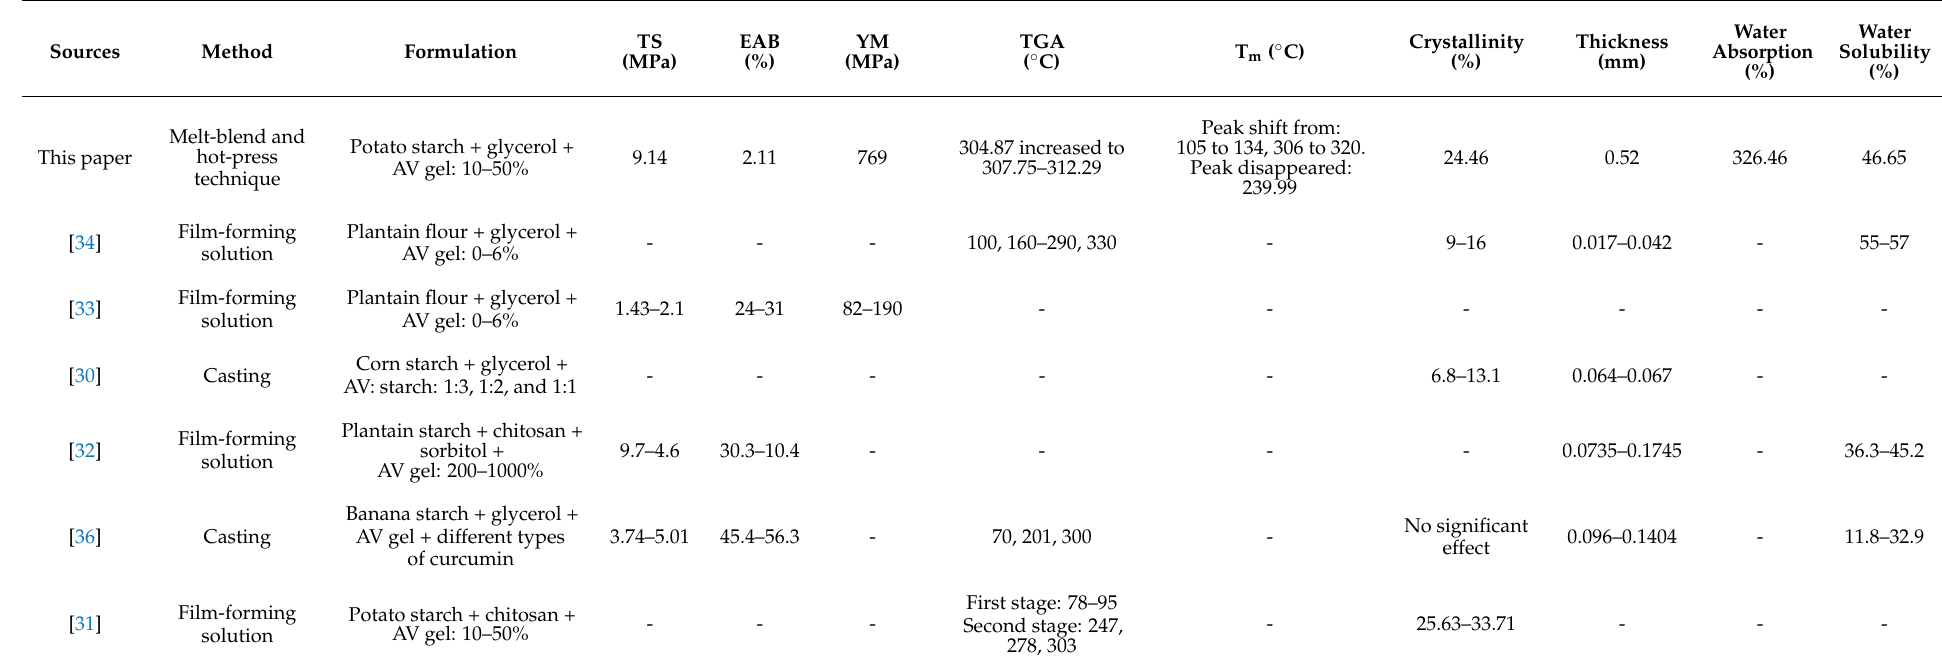
Table 3. Comparison with other